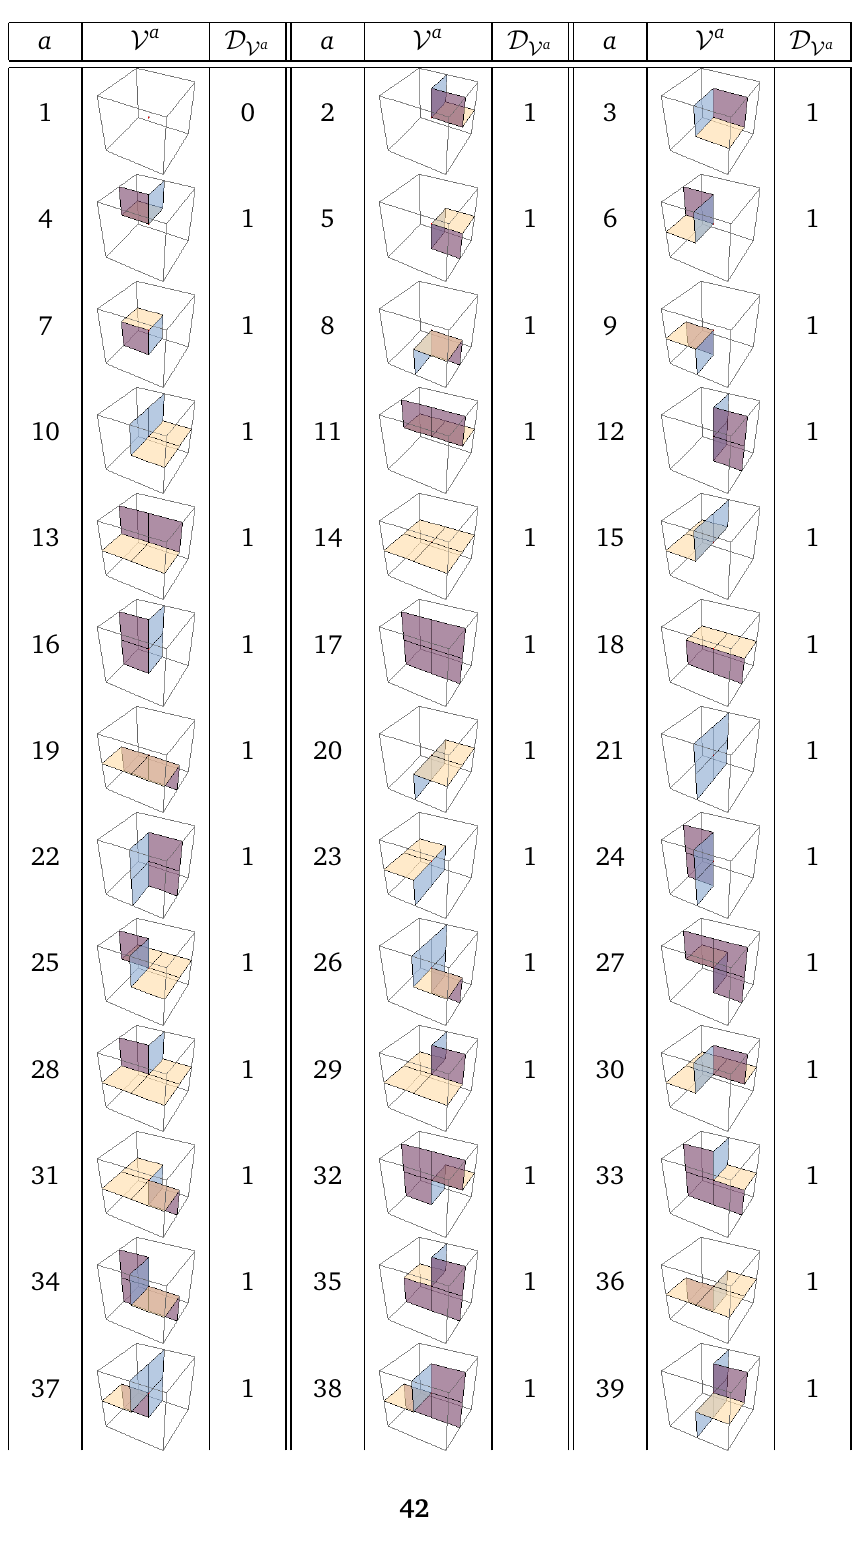
Table 2: Table demonstrating results of vertex decomposition algorithm. a runs over all configurations, V a displays the pattern of domain walls, and D tex number assigned by the